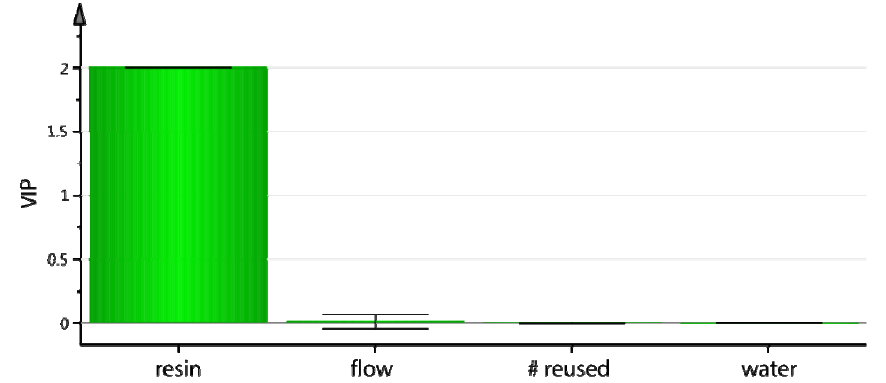
Figure 2. On-column [ 18 F]F − trapping using PS -P 2tBu : variables important for the projection (VIP) plot.